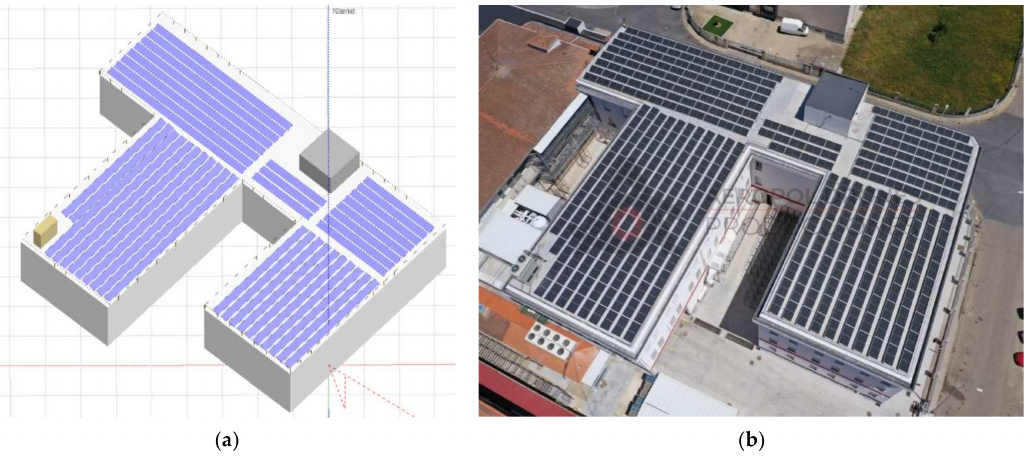
Figure 5. Industrial PVSCS ( a ) PVSYST model, view from the South. ( b ) Photograph of the plant.